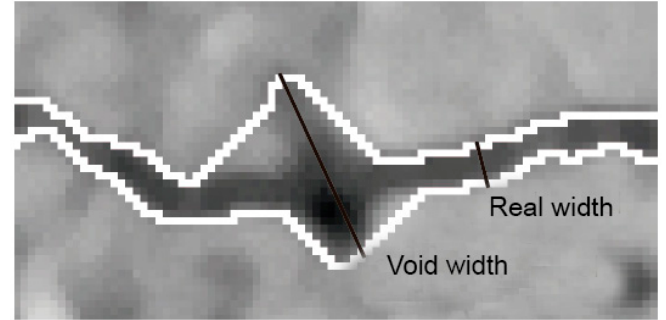
Figure 10. Crack opening width must be obtained from a mean value, due to the interference of voids.